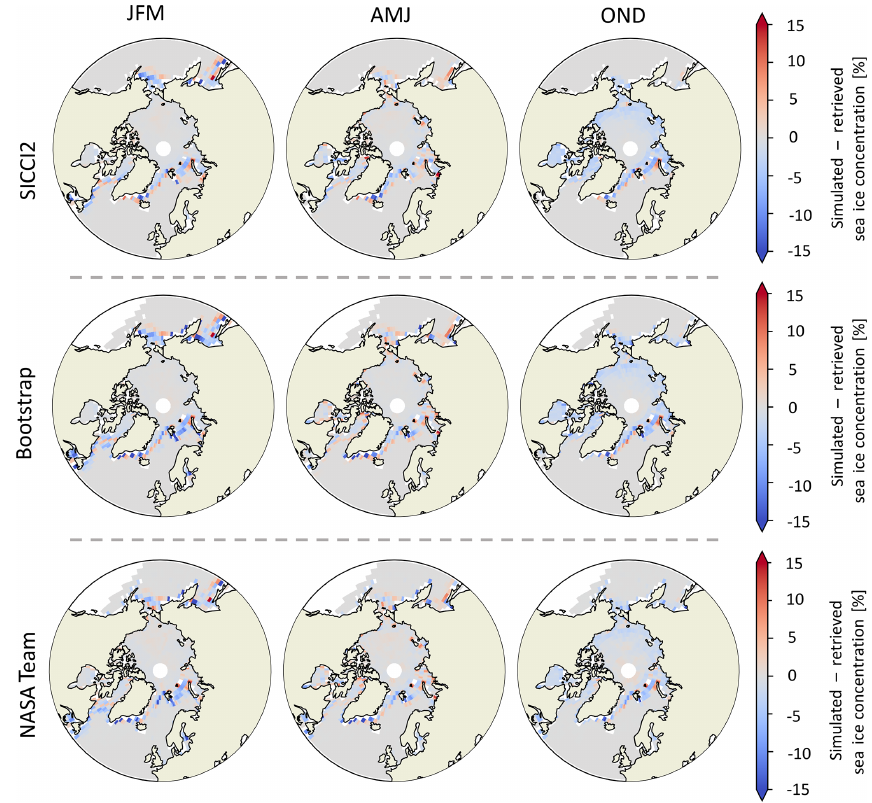
Figure 6. Difference between retrieved (before data assimilation) and simulated (after data assimilation) sea ice concentration for the three assimilation runs.